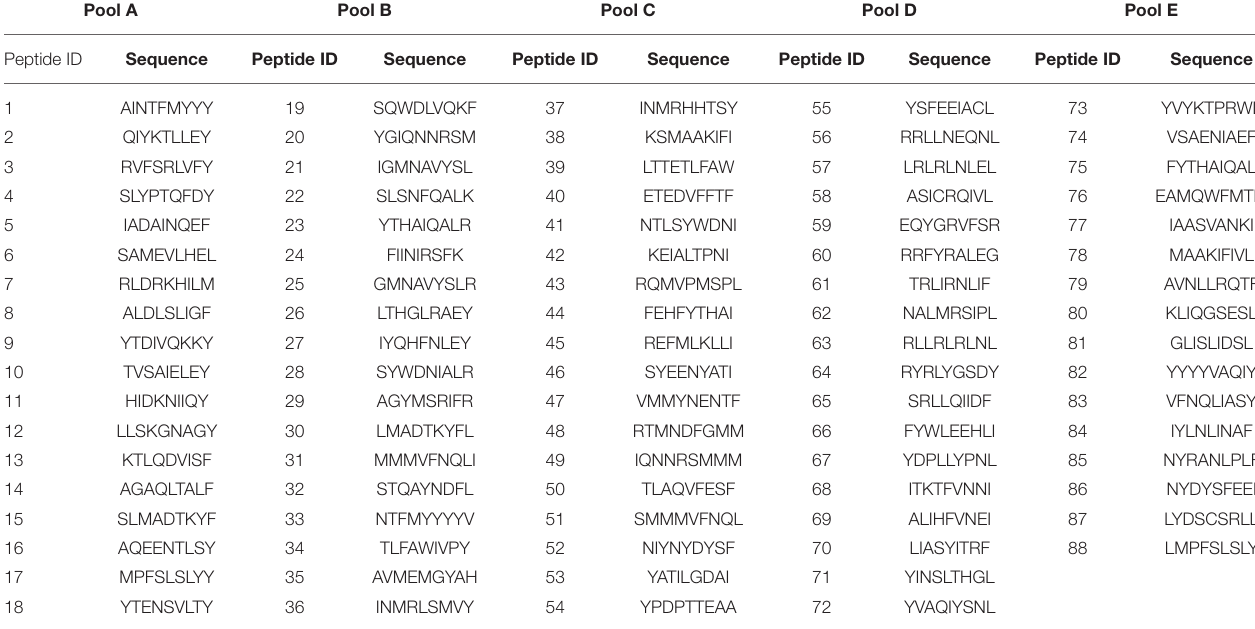
TABLE 2 | Predicted SLA -I binding peptides from ASFV pp220 (Georgia 2007/1). Pool A Pool B Pool C Pool D Pool